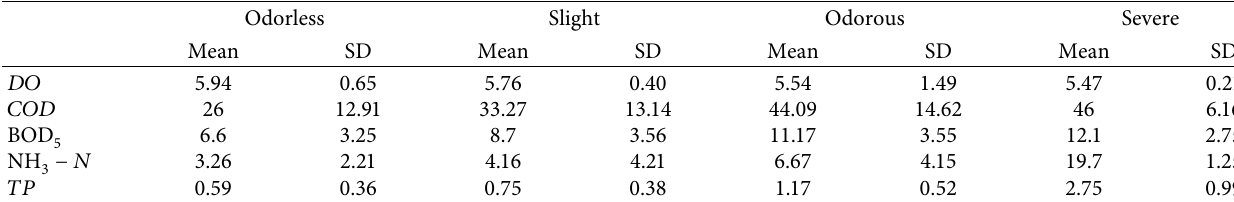
Table 2: Mean and standard deviation of the odor model.